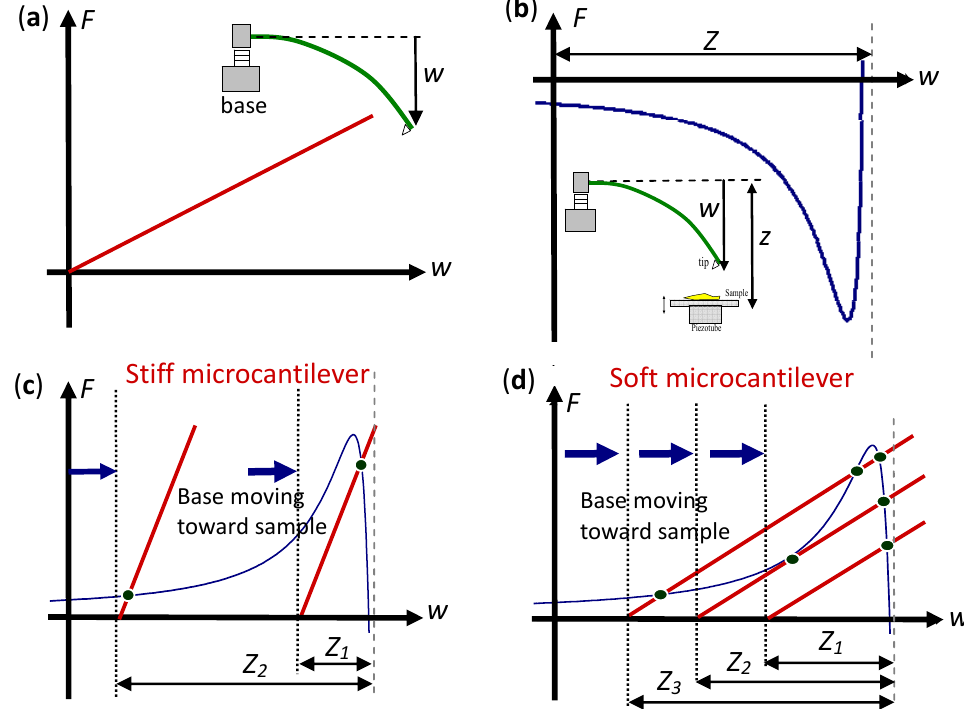
Figure 2. ( a ) Force-displacement relationship for microcantilever. ( b ) Force-displacement relationship for the LJ potential curve. ( c ) For a stiff microcantilever, cases of single cross point are shown. ( d ) For the soft microcantilever, cases of one, two, and three cross points are shown.